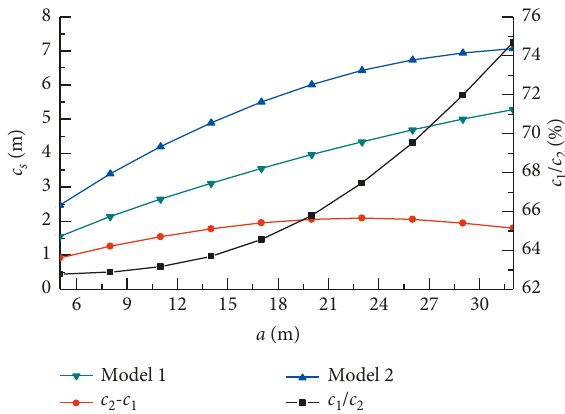
Figure 7: Diagram of the minimum thickness with the orebody thickness.